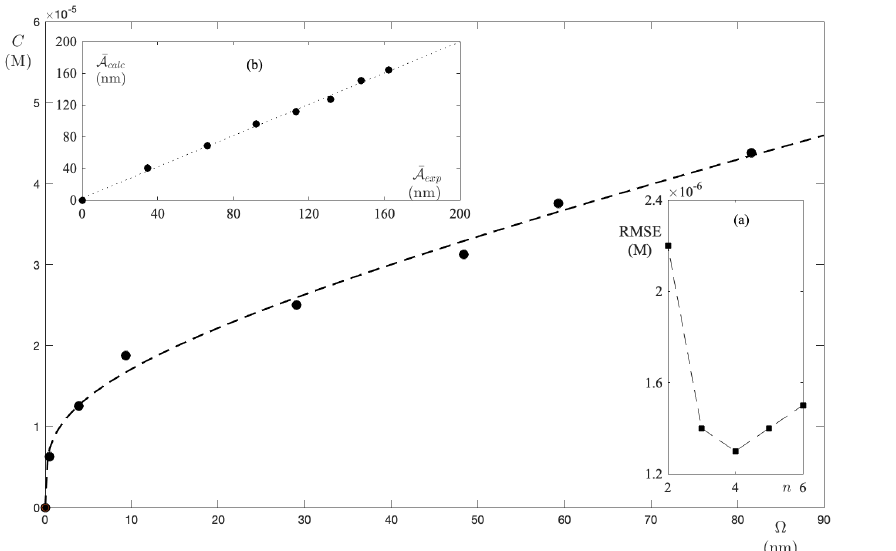
Figure 9. MB molar concentration in UPW as a function of excess absorbance. The dashed curve is the result of fitting to the model equation with n = 4. Panel ( a ) displays the RMSE for each test performed at a different n . Panel ( b ) shows the strong correlation between the integral absorbance when it is recalculated with the new parameters and the experimental